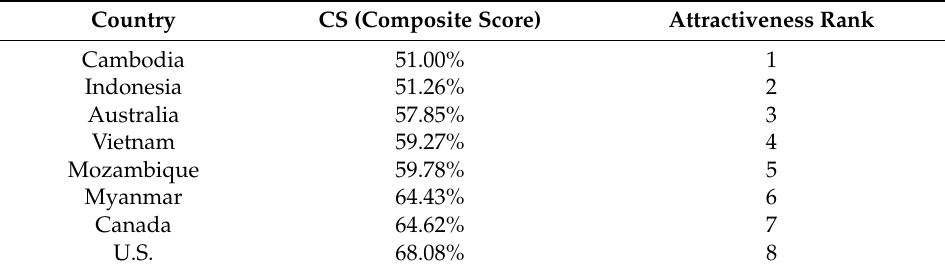
Table 8. CS Value and Attractiveness Rank of Eight Countries.